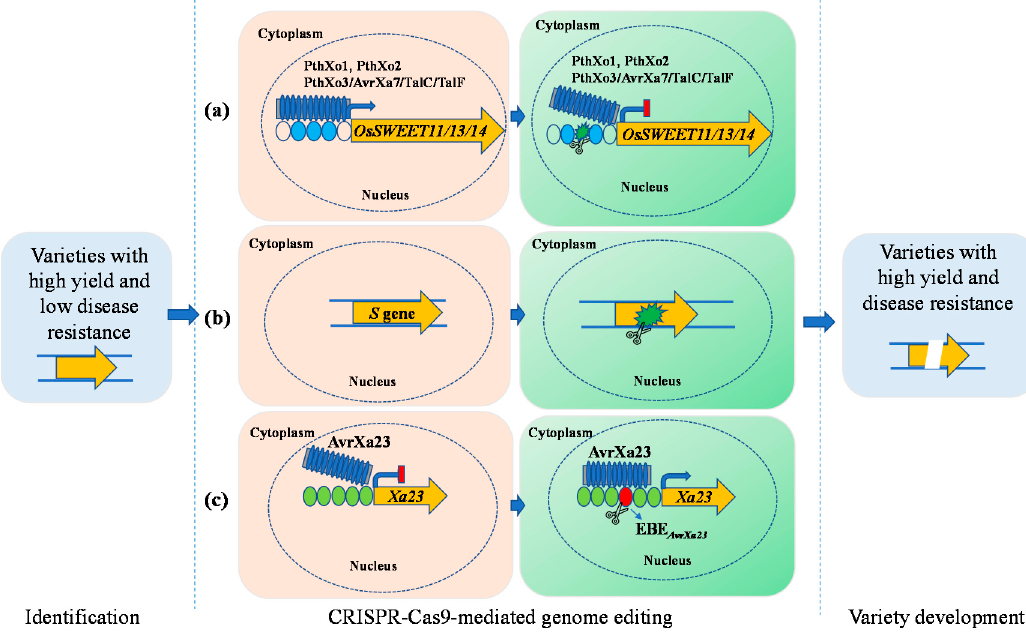
Figure 2. Engineering broad-spectrum disease-resistant rice by editing susceptibility and executor R genes. ( a ) Editing the EBEs (effector-binding elements) of S genes OsSWEET11 , OsSWEET13 , and OsSWEET14 ; ( b ) disruption of S genes; ( c ) editing the EBEs of executor R gene by CRISPR/Cas9-mediated precise homology directed repair.